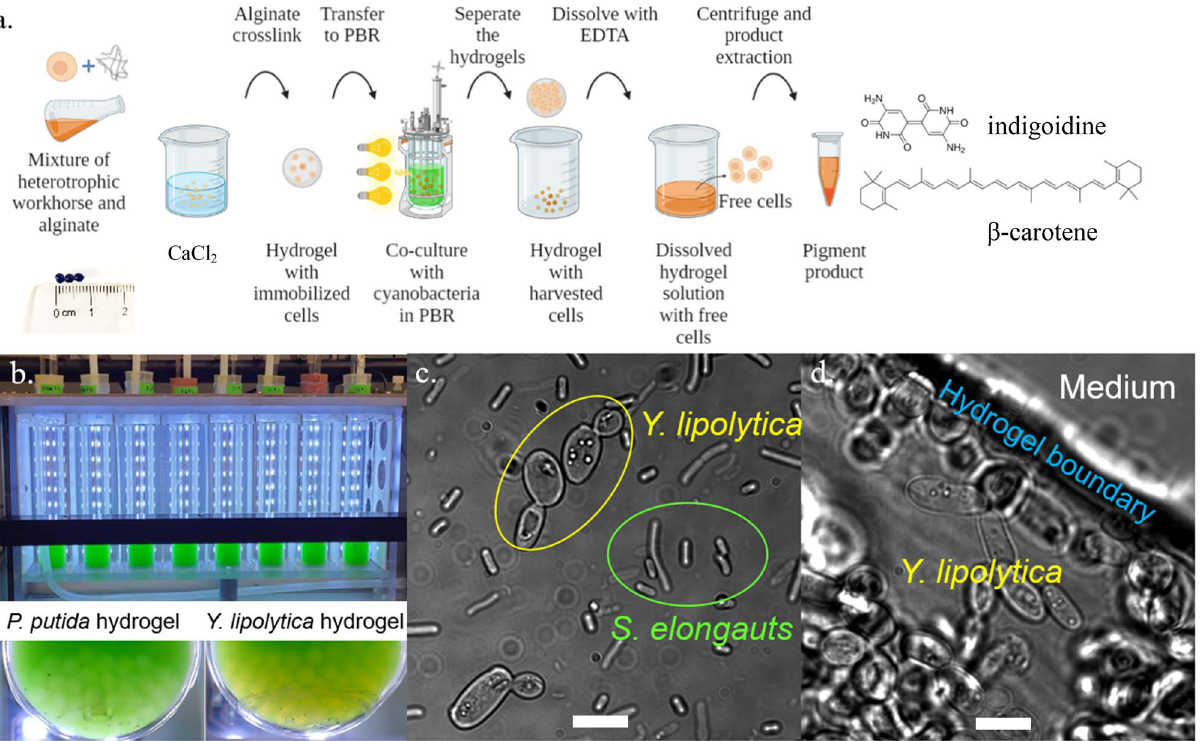
Figure 5. Co-culture illustration diagram, multi-cultivator setup, and microscope images of co-culture and hydrogel. ( a ) Schematic illustration of co-culture bioproduction process. Created with BioRender.com. ( b ) Picture of the multi cultivator with P. putida and Y. lipolytica embedded hydrogels. ( c ) Optical microscope image of free cell S. elongatus/Y. lipolytica co-culture. ( d ) Optical bright field microscope image of hydrogel free cell S. elongatus / Y. lipolytica co-culture, × 100 magnification. Scale bars are 10